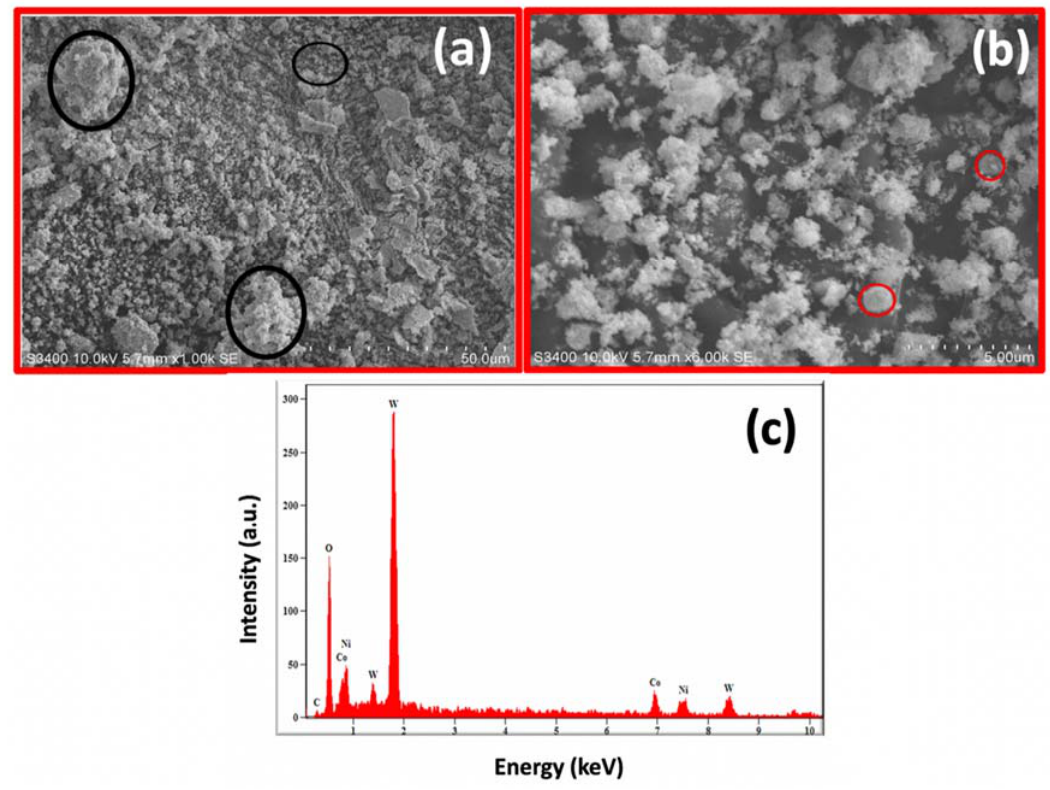
Figure 4. SEM images ( a , b ) with different magnification images and EDX spectrum ( c ) of Ni-CoWO 4 NPs.